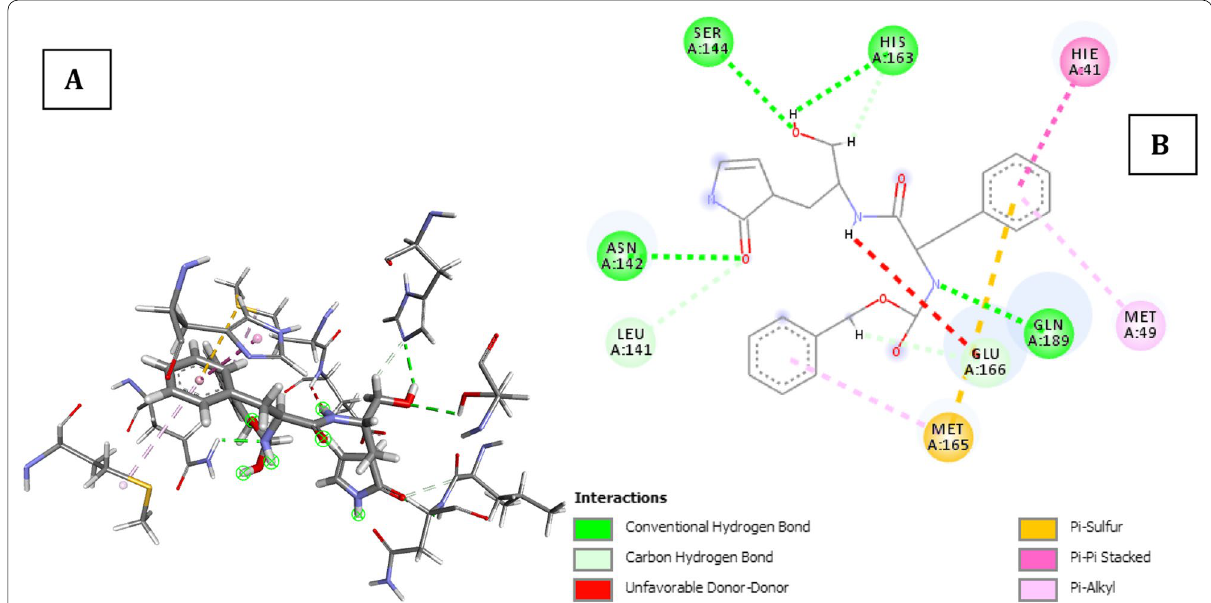
Fig. 1 Docked poses of SARS COV-19 main protease (PDB ID: 6XBH) with REF-IN (stick figure) a 3D view of REF-IN with surrounding amino acids of 6xbh; b 2D view of interaction type of REF-IN with surrounding amino acids of